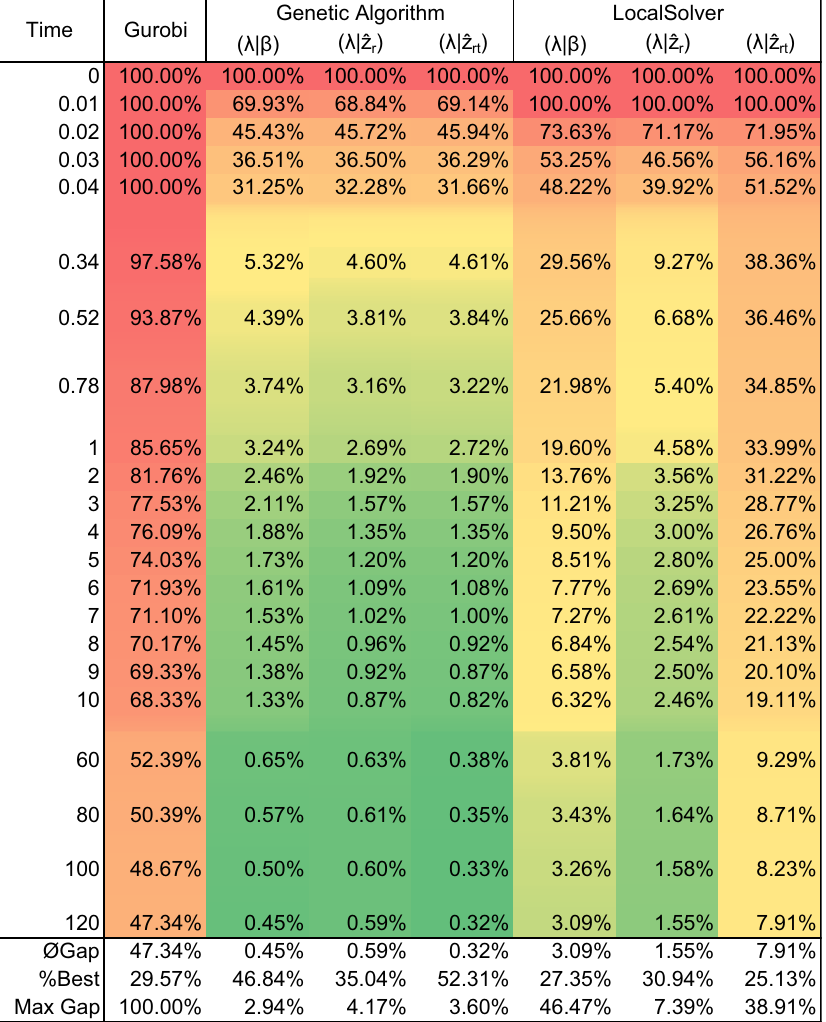
Table 6 Numerical results over time for largeprojects with 120 non-dummy activities